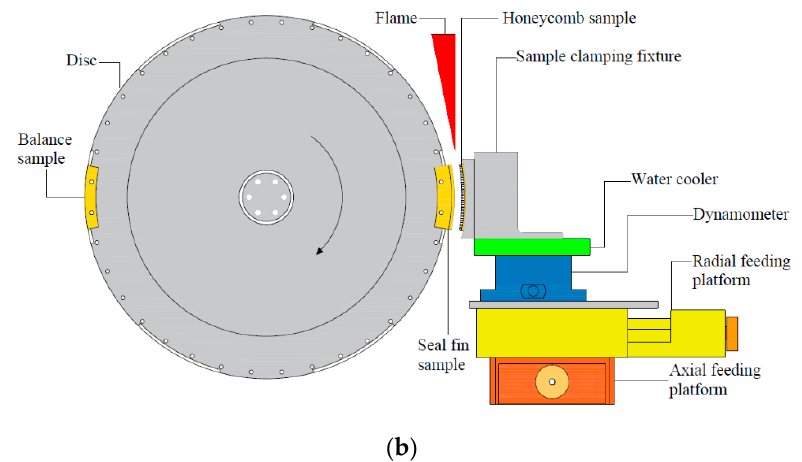
Figure 2. ( a ) Test rig; ( b ) test rig schematic diagram.